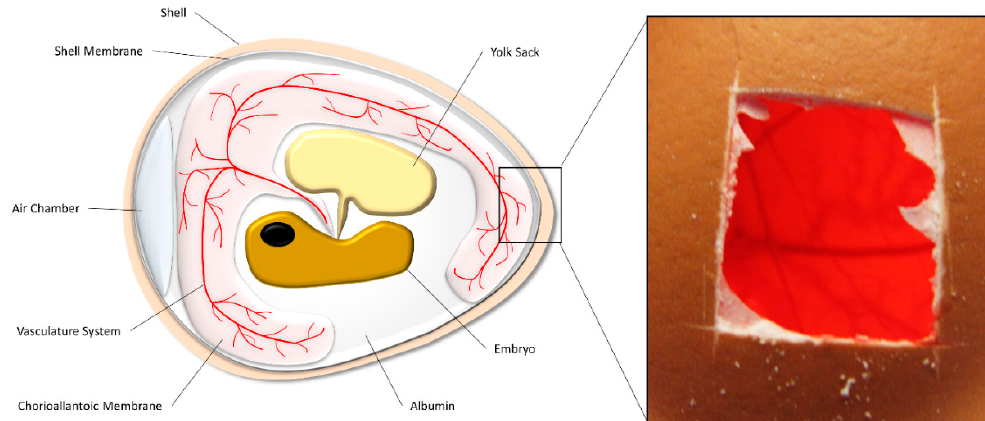
Figure 2. Structural composition of a chicken egg. The chorioallantoic membrane (CAM) is a membrane that covers the inside of the eggshell, where it acts as a respiratory organ for the chick embryo. A window can be made in the shell and the sample of interest placed on the CAM.